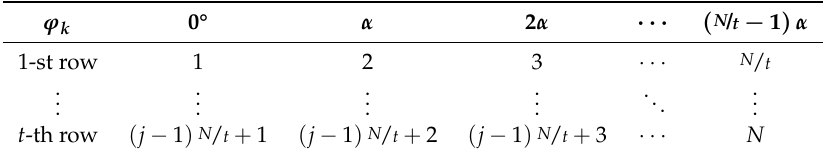
Table 3. Electrical angles of the star of slots ( j = 1, ..., t ). ϕ k